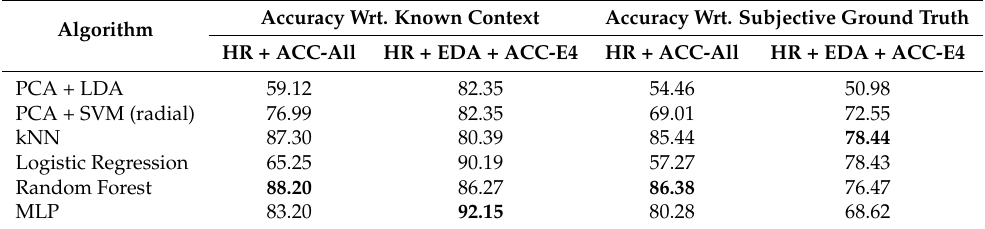
Table 13. Classification accuracies comparison of subjective report and known context. On the left, known context information (Free,1; Lecture, 2; Contest, 3) was used as class labels. On the right, subjective ground truths are used as class